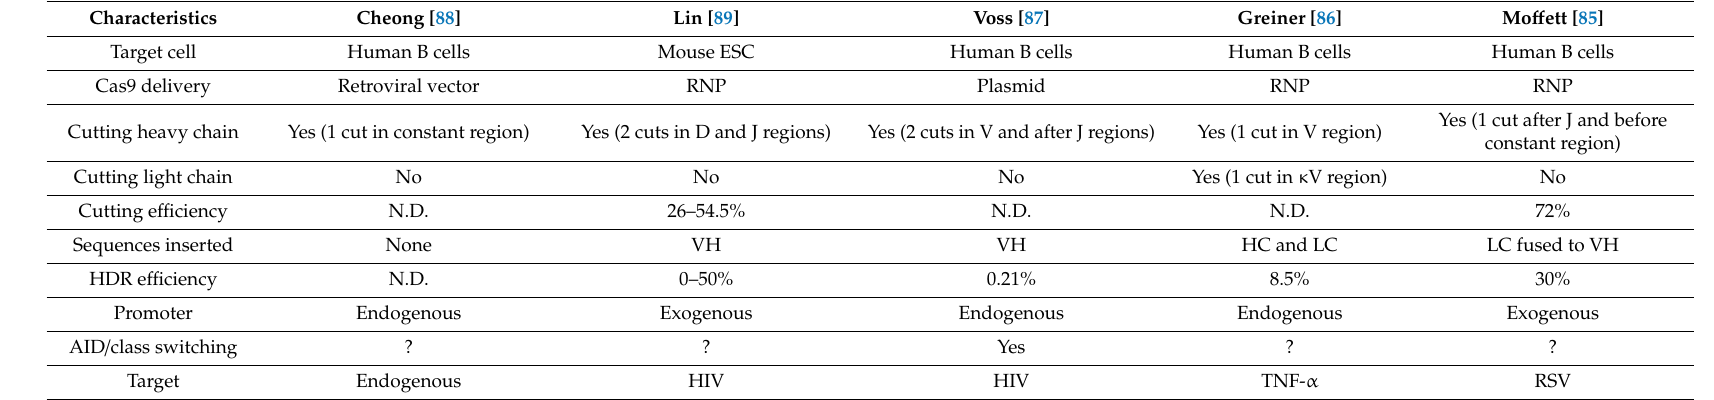
Table 1. Characteristics of endogenous BCR editing